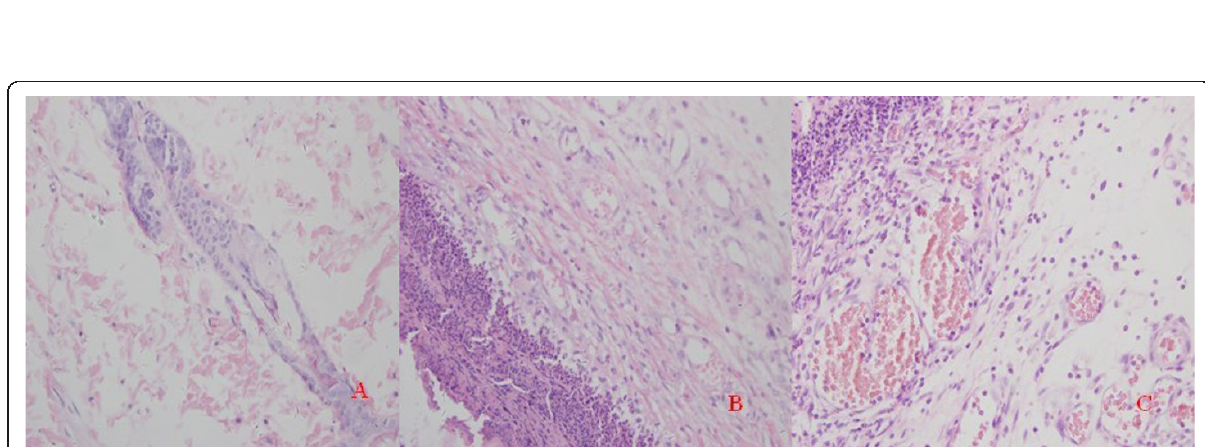
Figure 3 Histological compare in the character of wound healing on day 3 . (100 × magnification). A: group Ⅰ ; B: group Ⅱ ; C: group